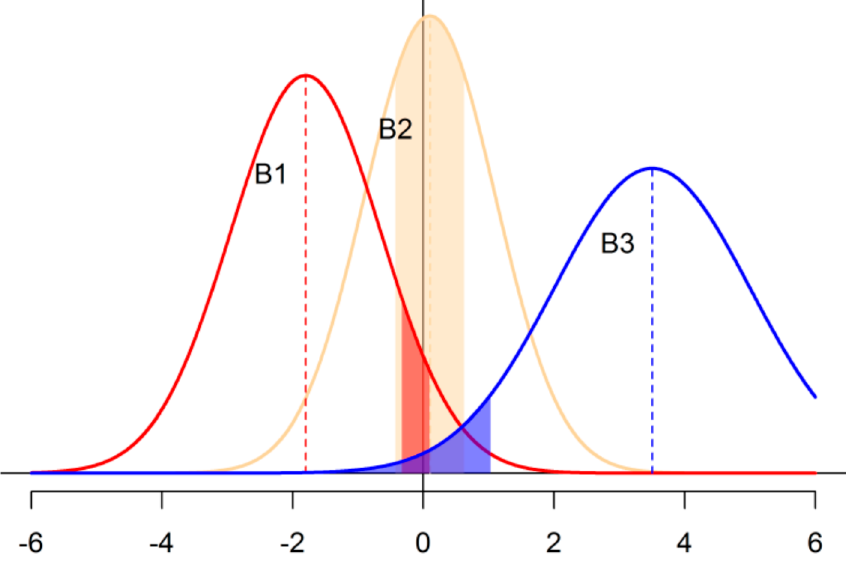
Figure A5. Examples (B1 to B3, see text) for deriving significance levels of negative or positive soil nutrient balances.